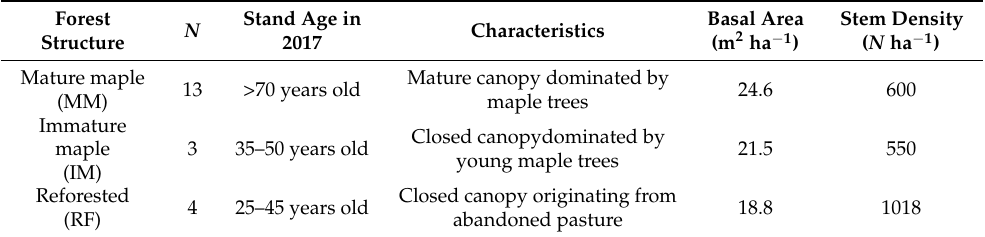
Table 1. Characteristics of the 20 study stands divided in three different types of forest structure commonly occurring in the region. Value ranges are shown for stand age, and average values are shown for basal area and stem